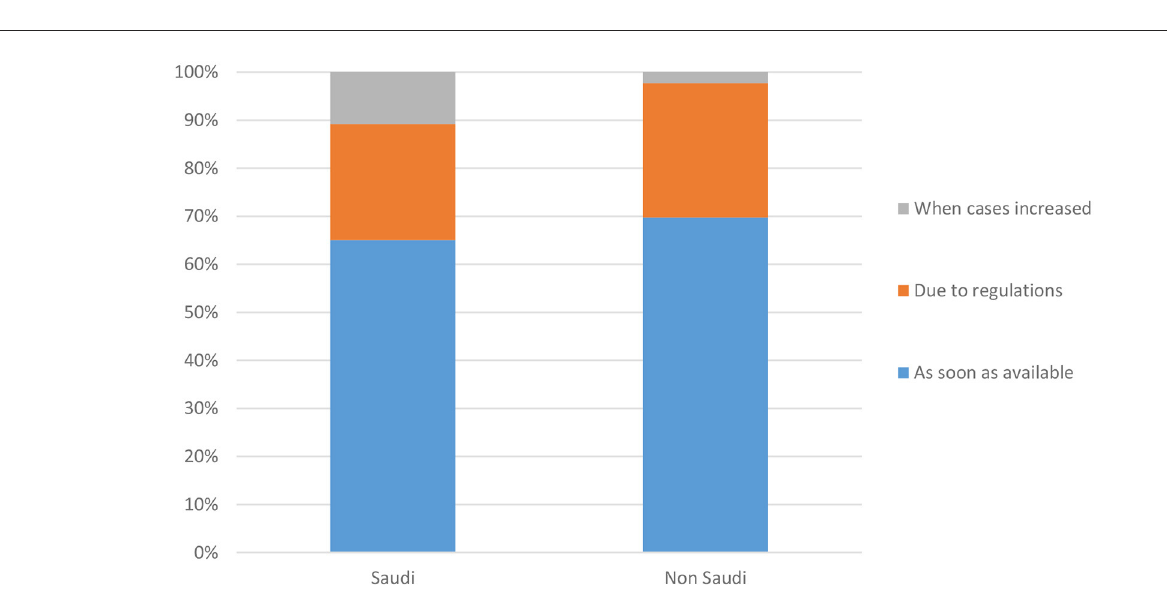
FIGURE3 Nationality differences when respondents registered for the